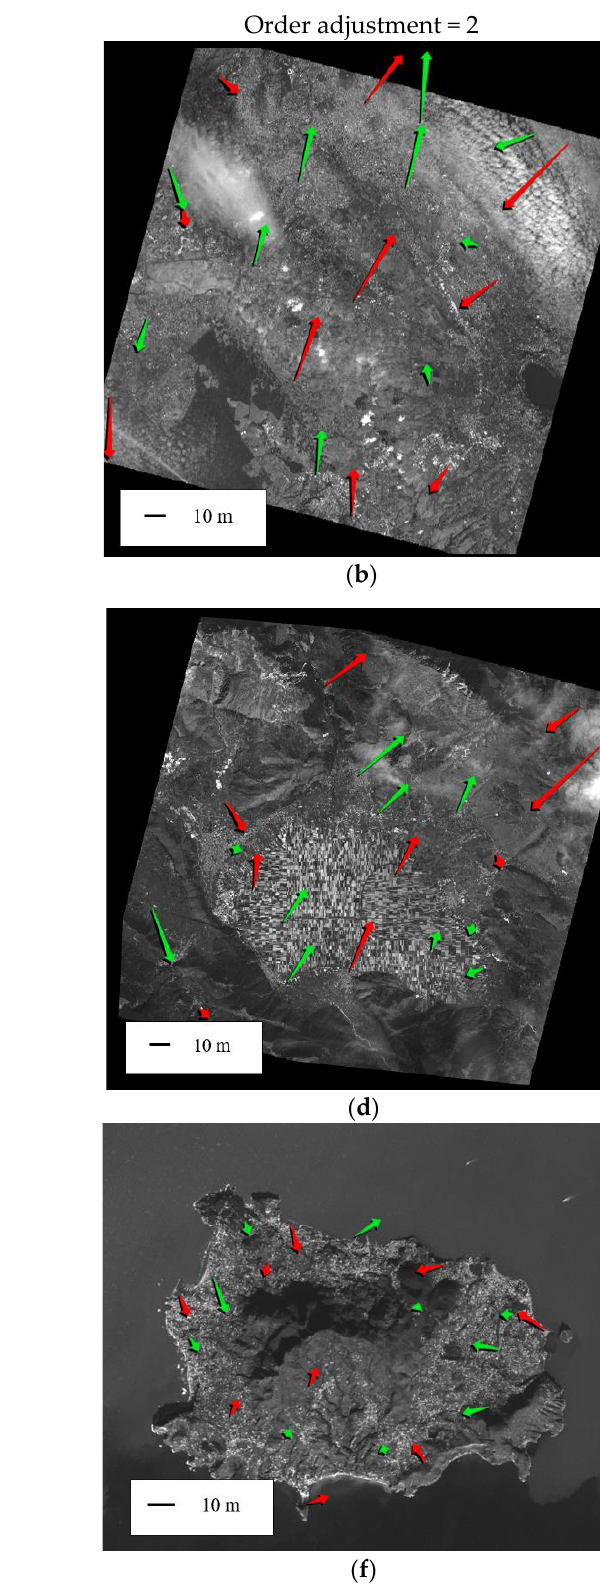
Figure 9. The planimetric errors — RPC model with no refinements applied, test field of Rome ( a ), Fucino ( b ) and Ischia ( c ).